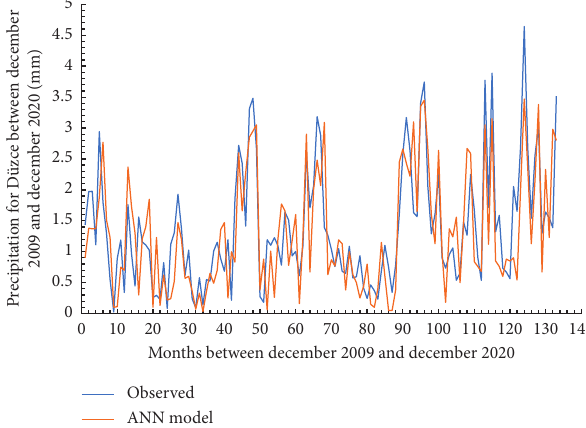
Figure 6: Observed and ANN predictions of daily average by month rainfall records (2009–2020).